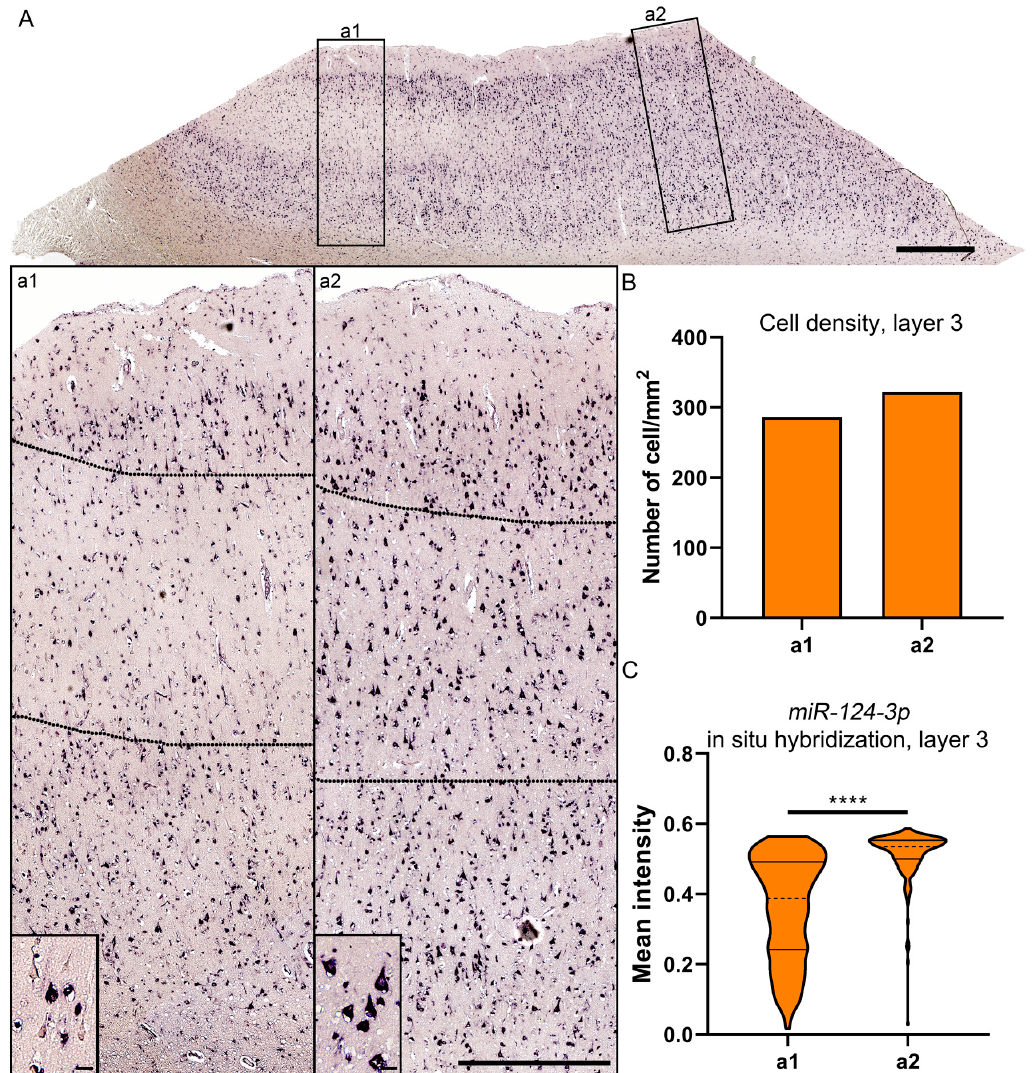
Figure 5. Expression of miR-124-3p in layer III cells of the lesioned cortex in a patient with severe TBI 5 days earlier. ( A ) Expression of miR-124-3p inside (a1) and outside (a2) the area with a visible loss of miR-124-3p. ( B ) Cellular density was comparable in the investigated areas. ( C ) Violin plots showing the greater variability in the distribution of the mean miR-124-3p signal intensity inside (a1) than outside (a2) the patchy neuronal loss region. The mean intensity of neuronal miR-124-3p in situ hybridization signal was lower inside than outside the lesion area ( p < 0.01). Statistical significance: **** p < 0.001. Scale bars: A 1000 µm; a1 and a2 1000 µm; insert in a1 and a2 20 µm.